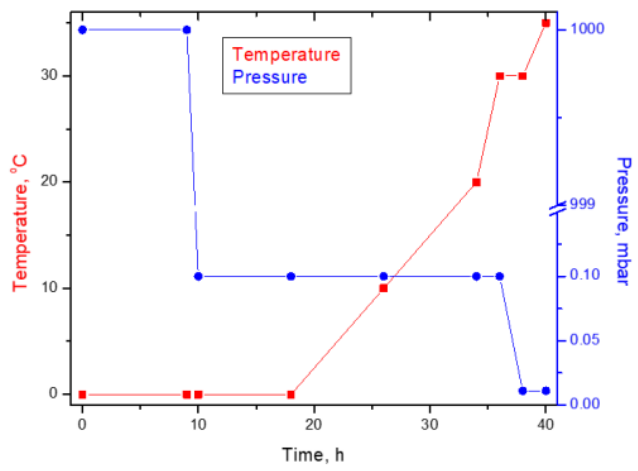
Figure 1. Freeze-drying chart for Saccharomyces pastorianus ssp. carlsbergensis W34/78.